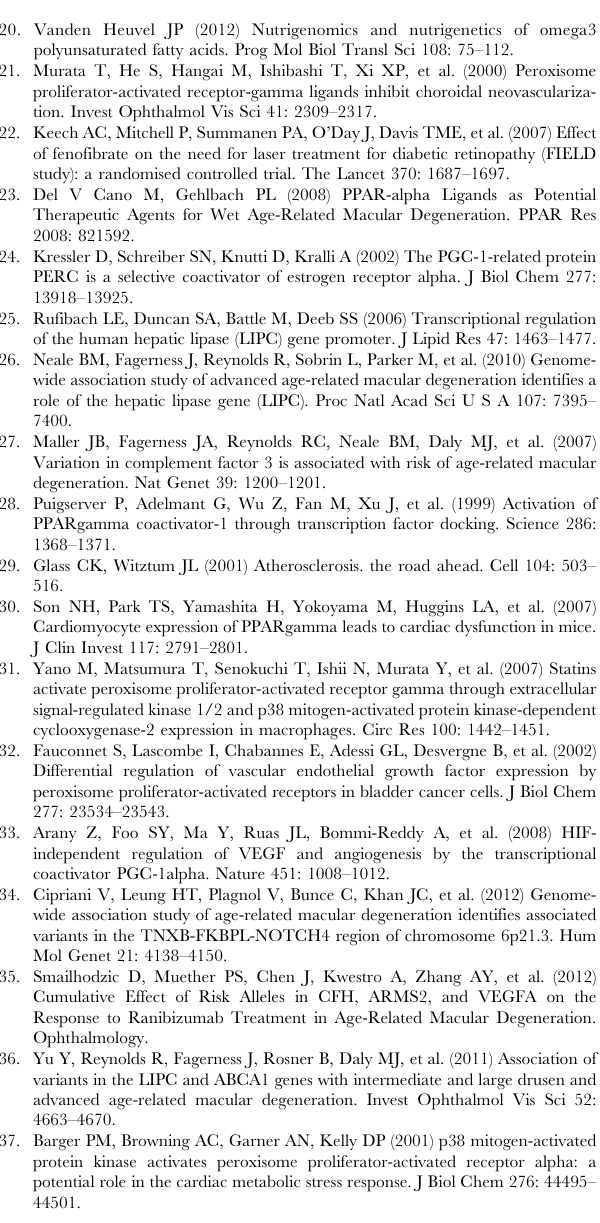
Table S1 NV AMD-associated variants in complement pathway genes, LIPC, and ABCA1. Abbreviations: CHR, chromosome; SNP, single-nucleotide polymorphism. Full names for the genes listed in the ‘Gene Symbol’ column exist at: http:// www.ncbi.nlm.nih.gov/gene. Combined estimates (OR meta ) were computed with age-, sex, and smoking-adjusted meta-regression – random effects models were applied in instances indicated by Cochrane’s Q statistic. All P values are